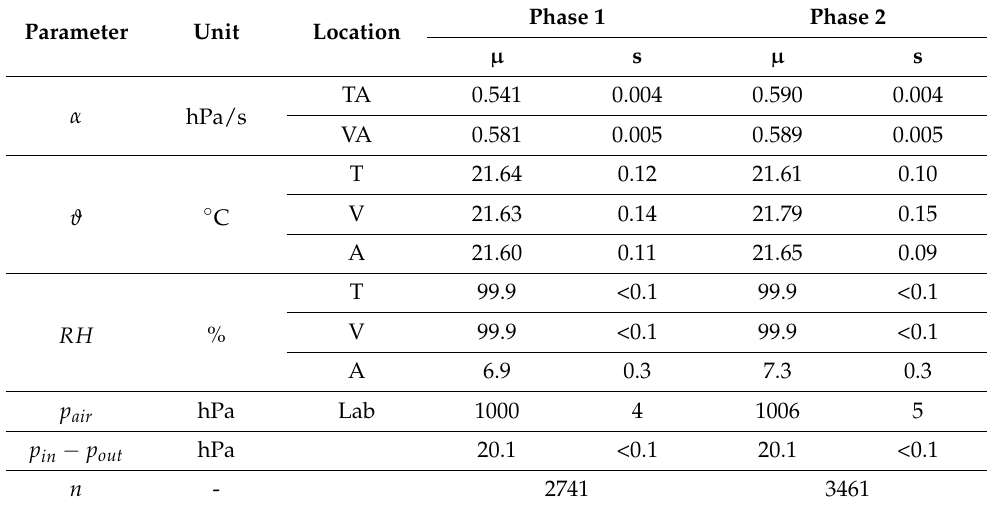
Figure A4. ( a ) Pressure changes analyzed for the test container (TA: red) and vapor container (VA: green) versus the air container. Gray regions represent data that were not included in further investigations. Data corrected using Equation (12) are shown in ( b ). The solid lines (TA: black, VA: blue) represent the calculated pressure changes. The orange box marked C indicates the change from Phase 1 to Phase 2. Table A5. Means ( µ ) and standard deviations (s) for Experiment 3.